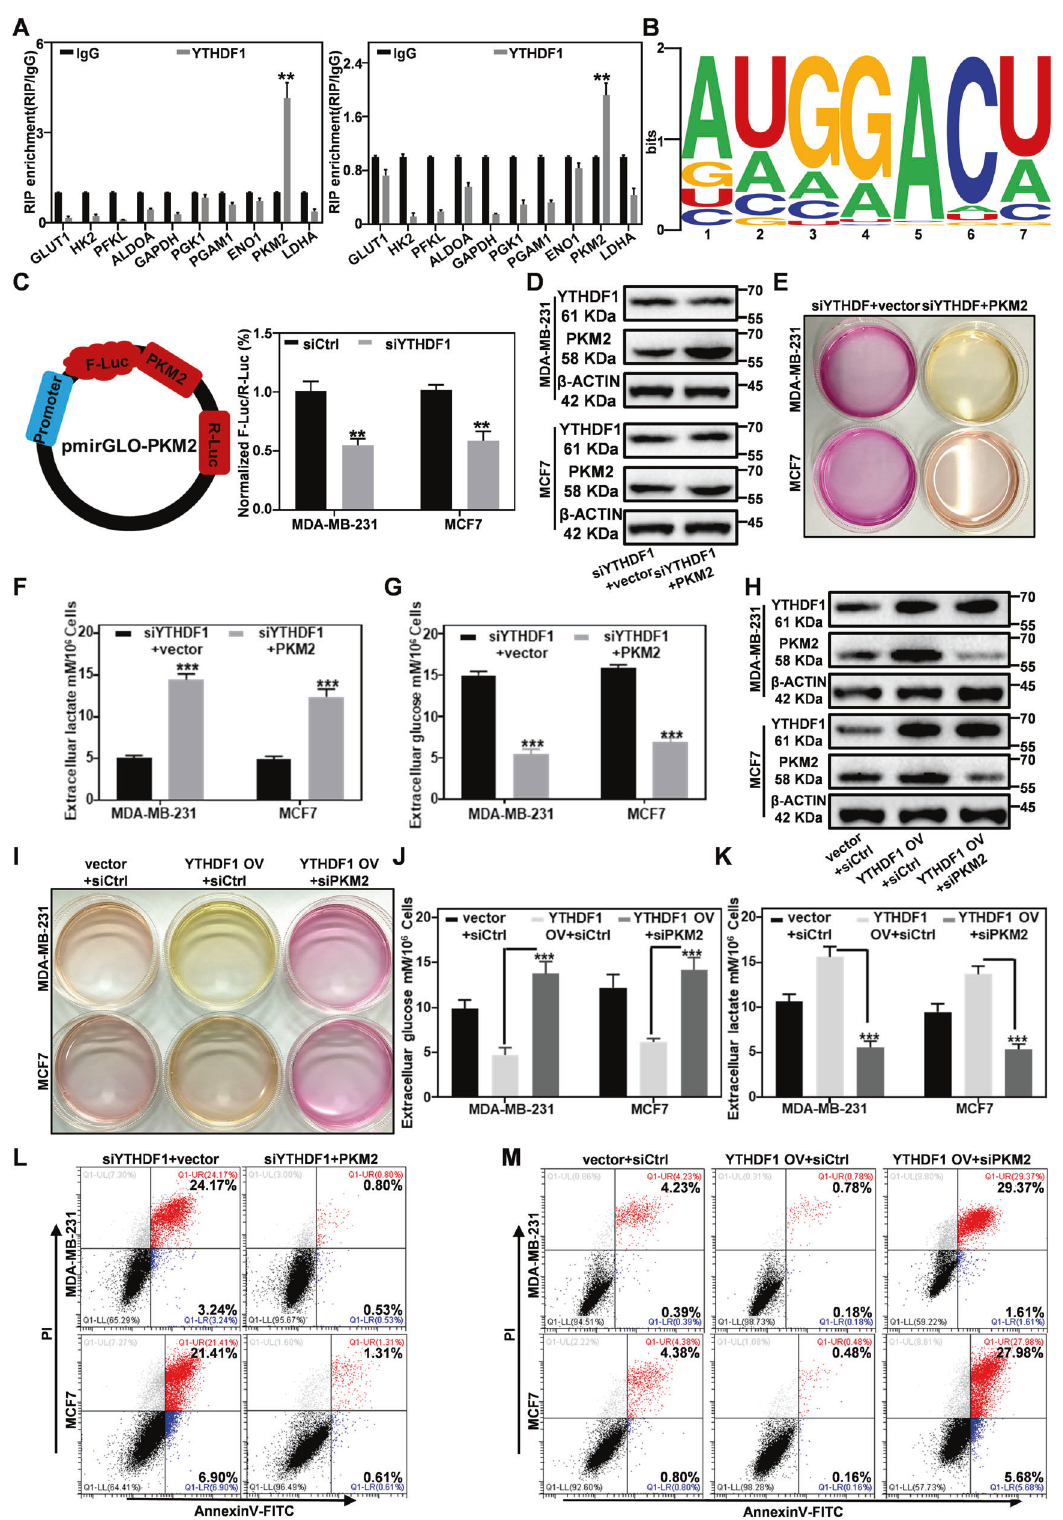
cancer cells. To further elucidate the role of YTHDF1 in the glycolysis regulation network of breast cancer cells, we employed qPCR to detect the changes in glycolysis-related genes after the RIP treatment with YTHDF1 antibody. The experimental results showed that PKM2 mRNA was ef fi ciently enriched by YTHDF1